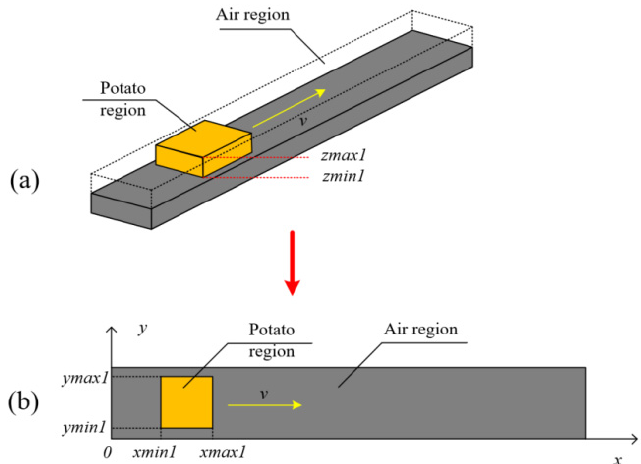
Figure 3. The schematic diagrams of conveyor belt areas: ( a ) 3-D diagram; ( b ) 2-D diagram.